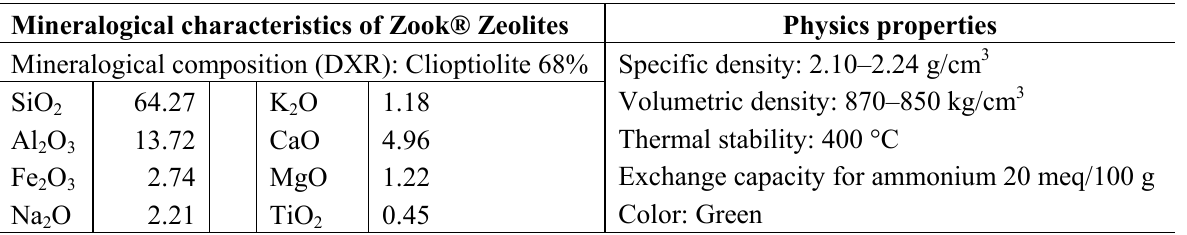
Table 1. Characteristic of zeolite investigated in this work from the island of Cuba. Mineralogical characteristics of Zook®